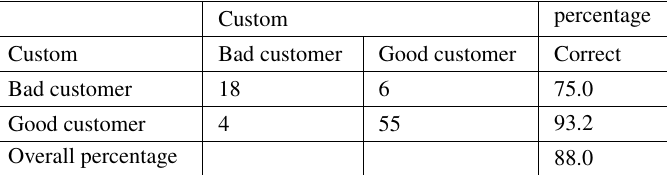
Table 7 Prediction of the model when the cut-off point is 0.5